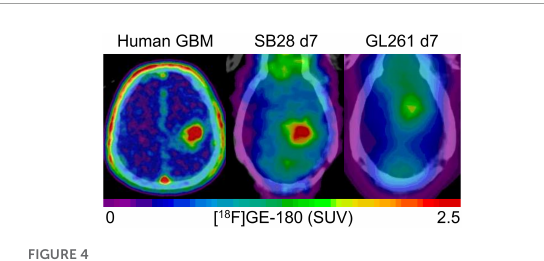
FIGURE4 Visual comparison of TSPO enrichment in human glioblastoma and week-1 SB28 and GL261 tumors in immunocompetent mice. The patient example shows a 77 year old male with initial diagnosis of glioblastoma [IDH-wild-type, TERT methylation (+), MGMT methylation (+)], who received a TSPO-PET prior to radiochemotherapy. SB28 tumors at week-1 in immunocompetent mice show similar TSPO-PET signal intensities with human glioblastoma whereas the commonly used GL261 tumor in the same host type indicates only faint TSPO tracer uptake at week-1. Effect sizes (Cohen’s d) of TSPO-PET imaging (SUVmean) at week-1 for the comparison of tumor and sham mice were 2.63 for SB28 mice and 0.01 for GL261 mice